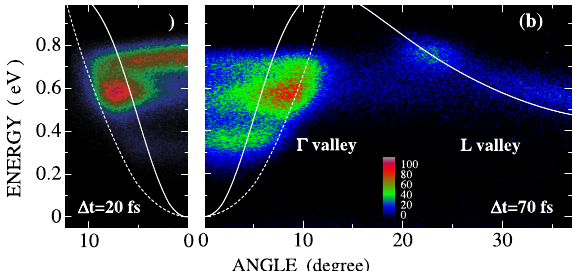
Figure 14. The experimental energy distribution function (EDF) in the conduction band of GaAs, obtained by two-photon photoemission spectroscopy (2PPES). The solid and dashed curves show the band dispersion along Γ -L and Γ -X directions, plotted as a function of angle, based on the band-structure calculation in Ref. [10]. Adapted with permission form [10], copyright American Physical Society, 2016. For more details, see